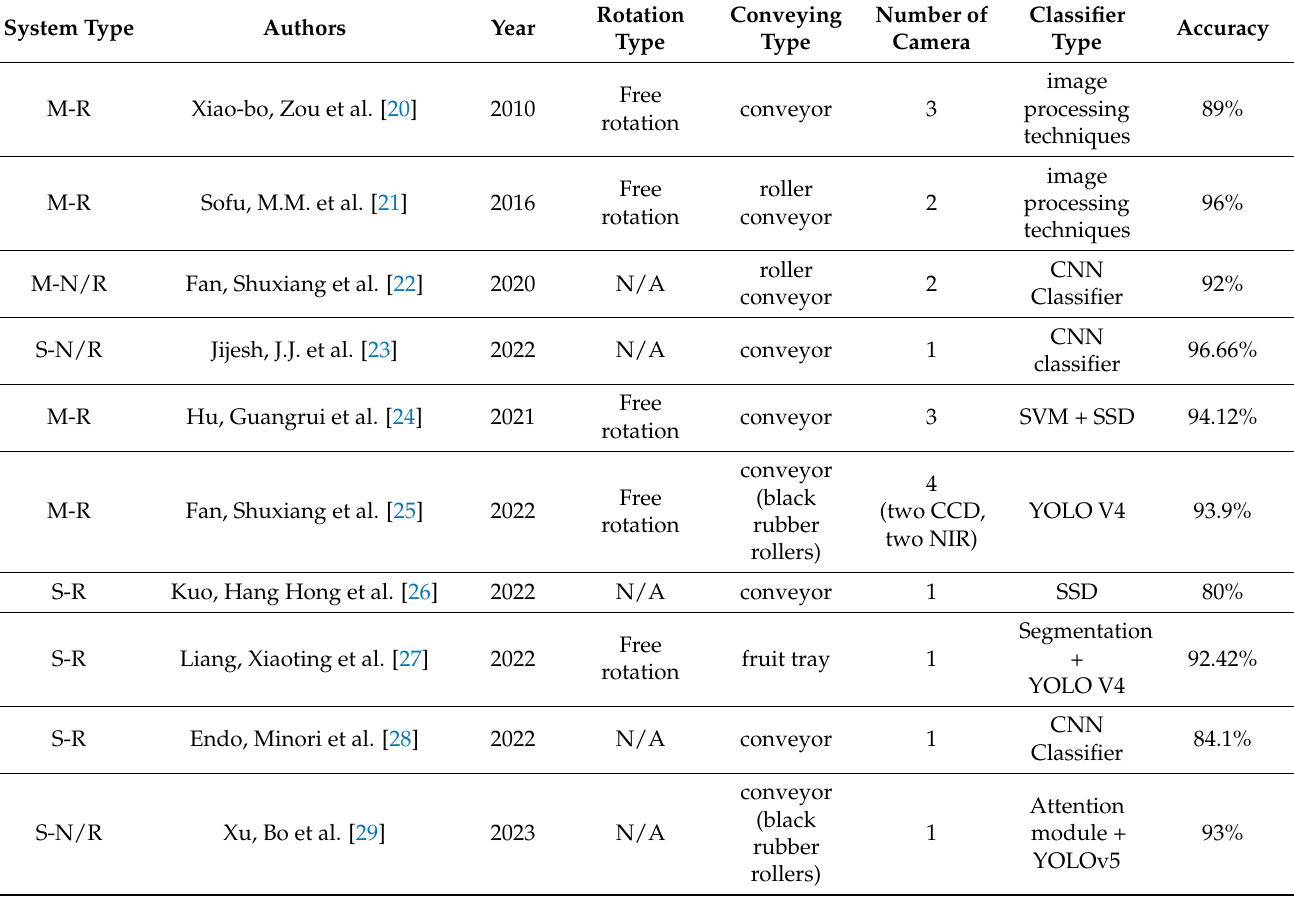
Table 1. Apple sorting system utilizing mechatronic components